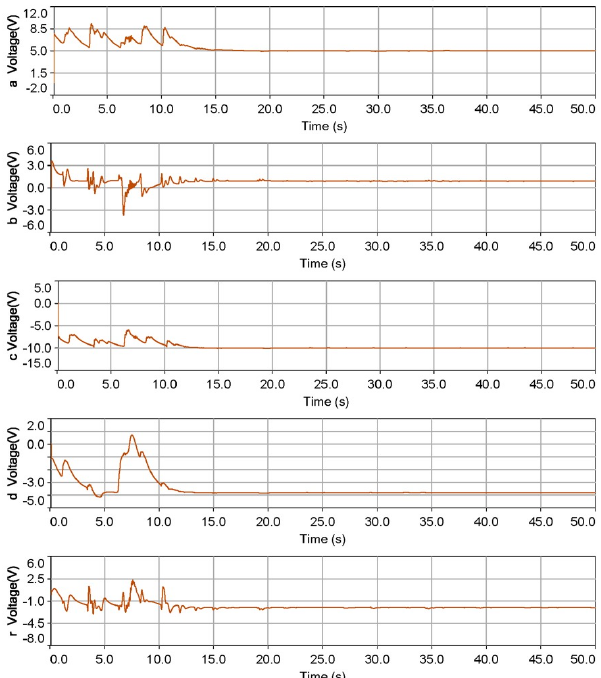
Figure 14. Time histories of the estimated parameters.